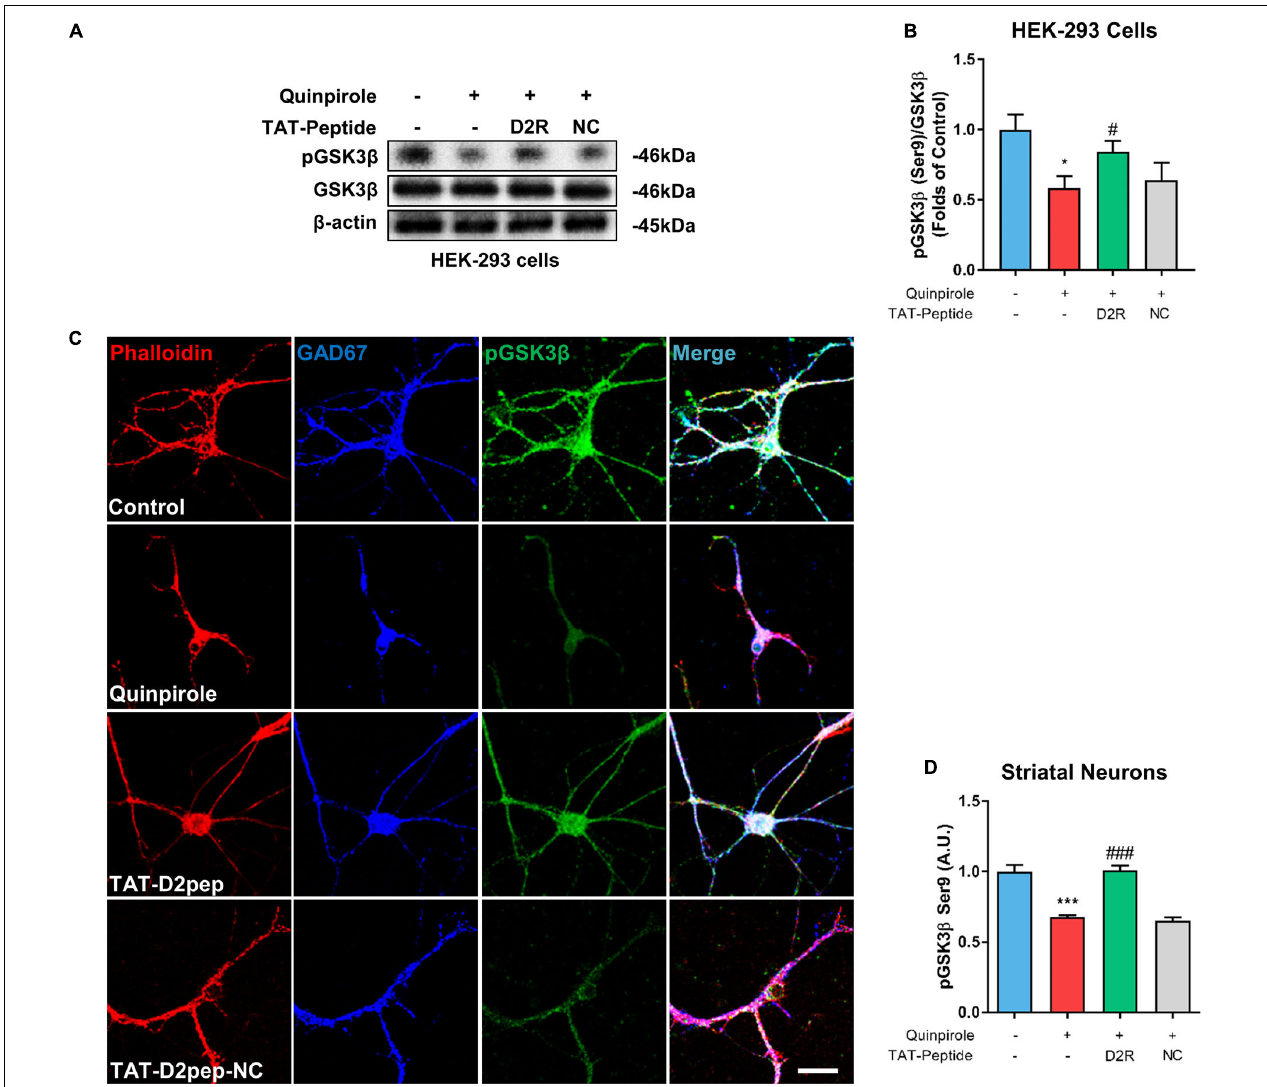
FIGURE 6 | TAT-D2pep protects neurites through increasing phosphorylation of GSK3 β in striatal GABAergic neurons. (A,B) Western blot analysis showed that TAT-D2pep increased downregulation of pGSK3 β in HEK-293 cells expressing D2R-EGFP and DISC1 mCherry; n > 3 per group. (C,D) Triple-immunostaining for phalloidin-actin, pGSK3 β and GAD67 in primary striatal neurons. TAT-D2pep blocked quinpirole-induced downregulation of pGSK3 β in striatal GABAergic neurons, accompanied by normal neurite growth. * P < 0.05 and *** P < 0.001 versus control, # P < 0.05 and ### P < 0.001 versus quinpirole by one-way analysis of variance (ANOVA) with post hoc Tukey